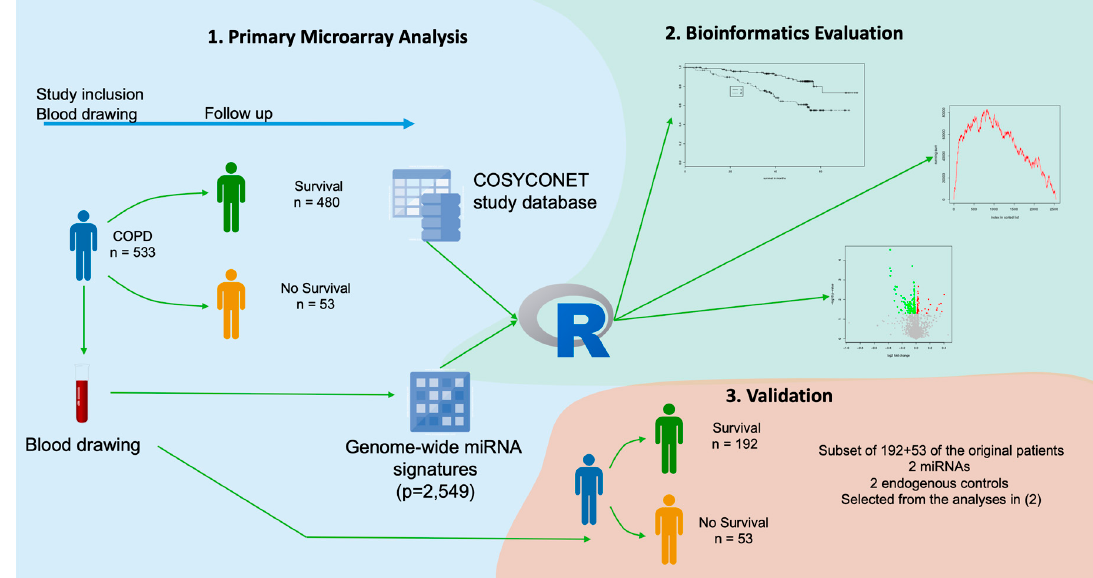
Figure 1. Overview of the study set up. The study consists of three parts: ( 1 ) a primary microarray-based screening, ( 2 ) a bioinformatics evaluation of the data and candidate selection, and ( 3 ) a validation in a subset of samples using RT-qPCR. Blood-born microRNA profiles were related to the survival of patients with chronic obstructive pulmonary disease (COPD) over a period of 54 months after diagnosis. COSYCONET: COPD and SYstemic consequences-COmorbidities NETwork.